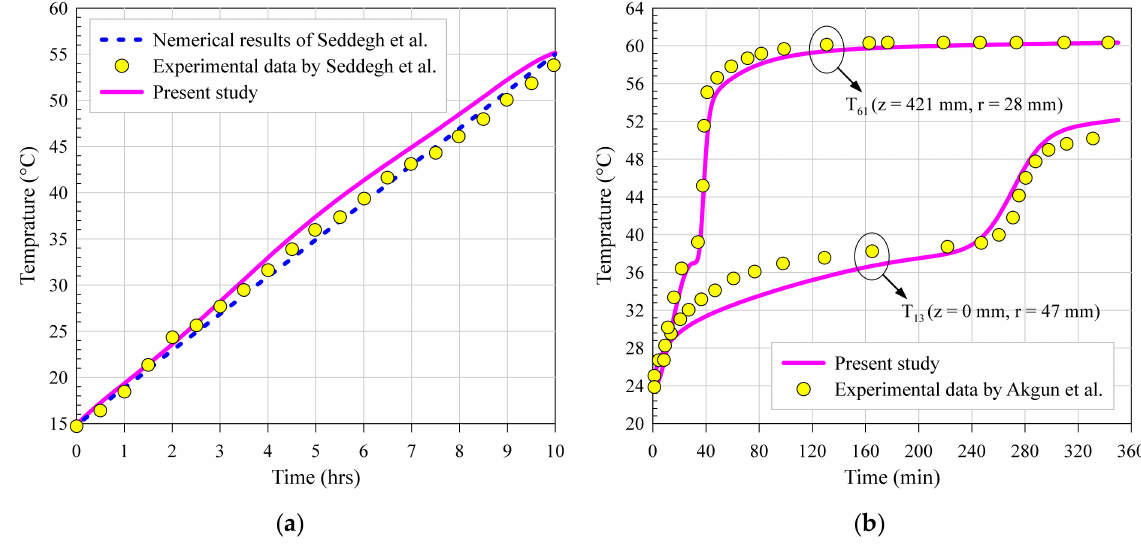
Figure 5. Comparison of transient PCM temperature between present numerical model and ( a ) numerical and experimental results of Seddegh et al. [116], ( b ) experimental data by Akgun et al.